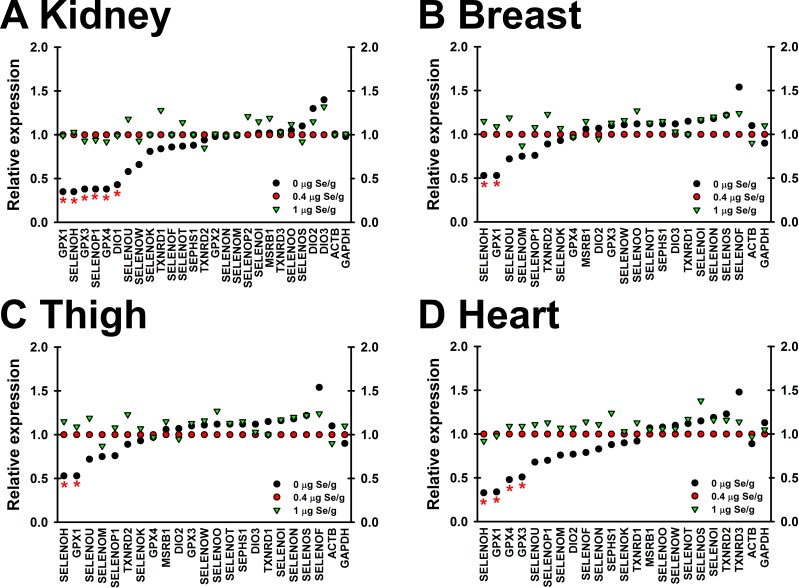
Effect of dietary Se on differential expression of selenoprotein transcripts.Transcript expression in kidney (A), breast (B), thigh (C), and heart (D) in poults supplemented with 0, 0.4 or 1 μg Se/g diet (n = 5/treatment), expressed relative to its level in Se-adequate (0.4 μg Se/g) poults. Asterisks indicate transcripts for which the effect of dietary Se was significant (p<0.05), as described in text.